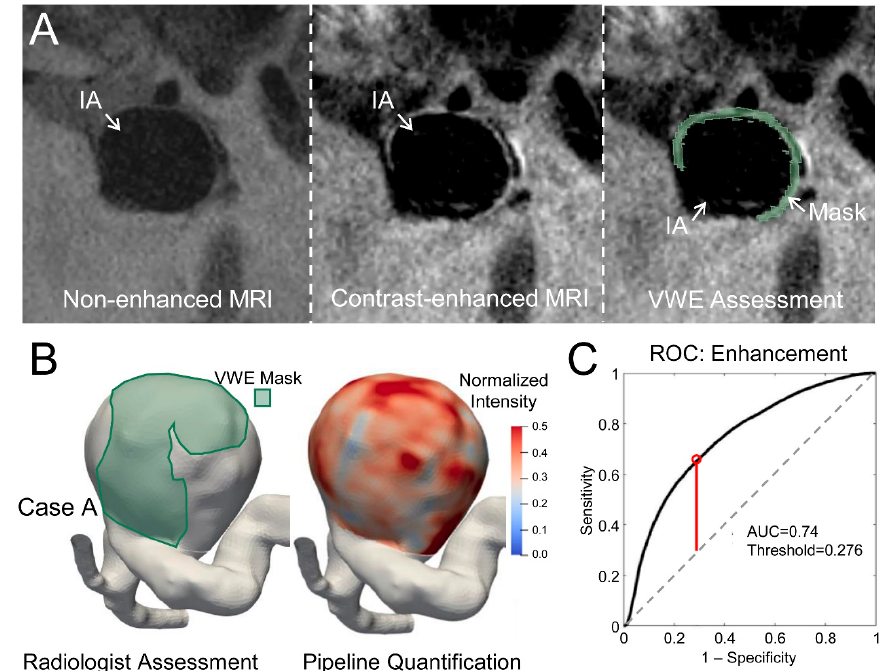
Figure 2. Identifying optimal threshold in the training dataset. ( A ). A cross-sectional slice of non-enhanced and contrast- enhanced MR images and the corresponding marked mask of a representative ICA case (Case A). ( B ). Reconstructed mask (marked in green) and the mapped intensities. ( C ). An ROC curve of the cumulative training set. The red line represents the location of maximal Youden’s J index.